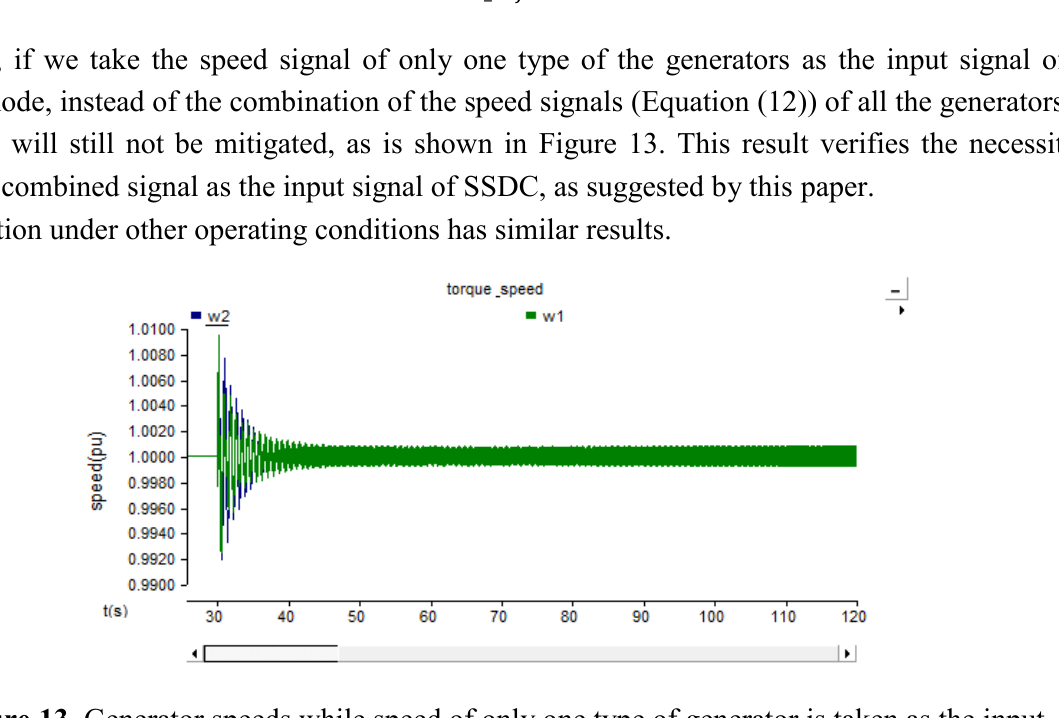
Figure 12. Output signal, ∆𝐼